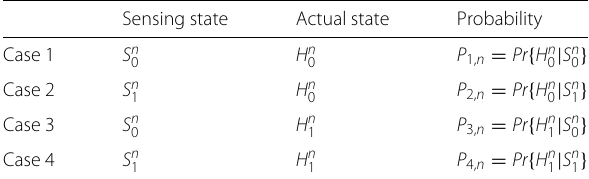
Table 1 Possibilities of spectrum sensing results for MUEs Sensing state Actual state